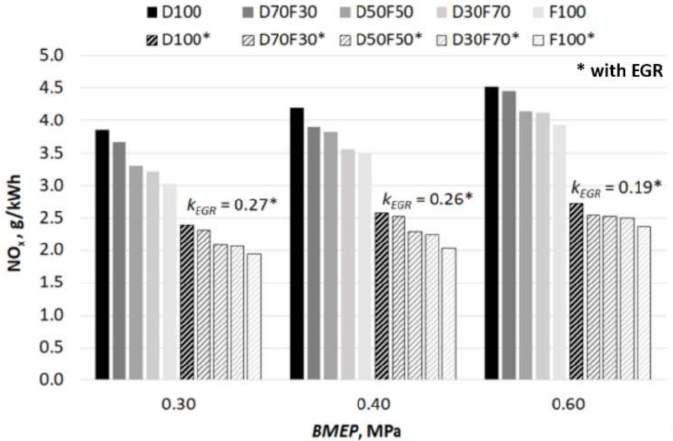
Figure 18. Dependence of nitrogen oxide (NO x ) emissions on fuel composition and the engine